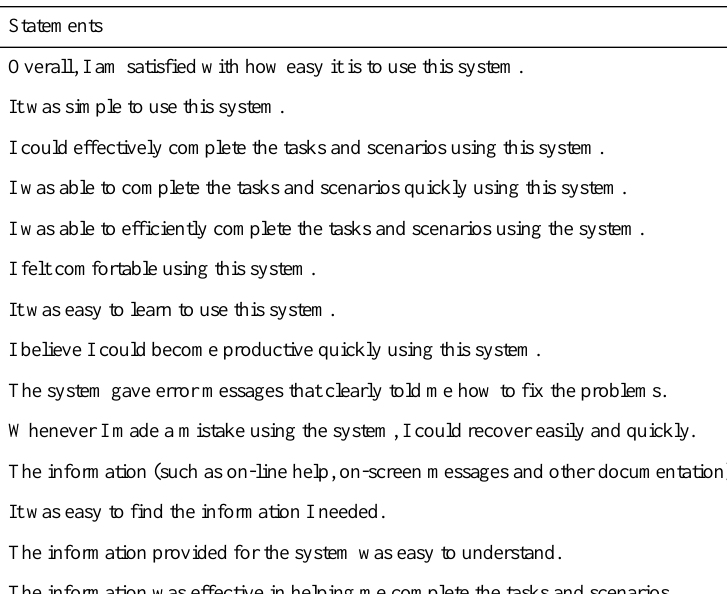
Table 4. Usability study